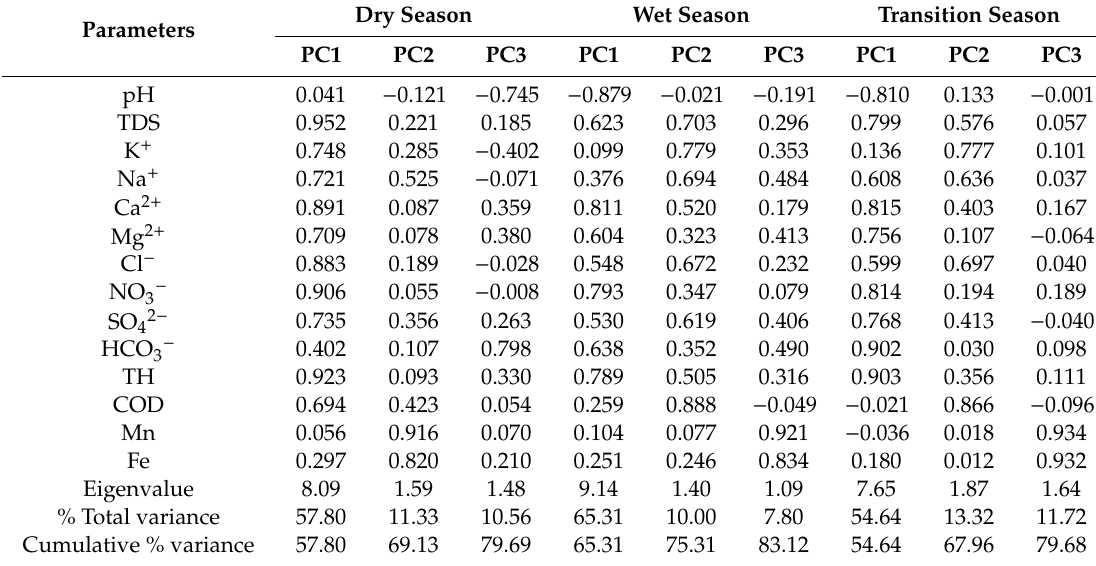
Table 3. Loadings of 14 selected variables on VARIMAX rotated factors of the three